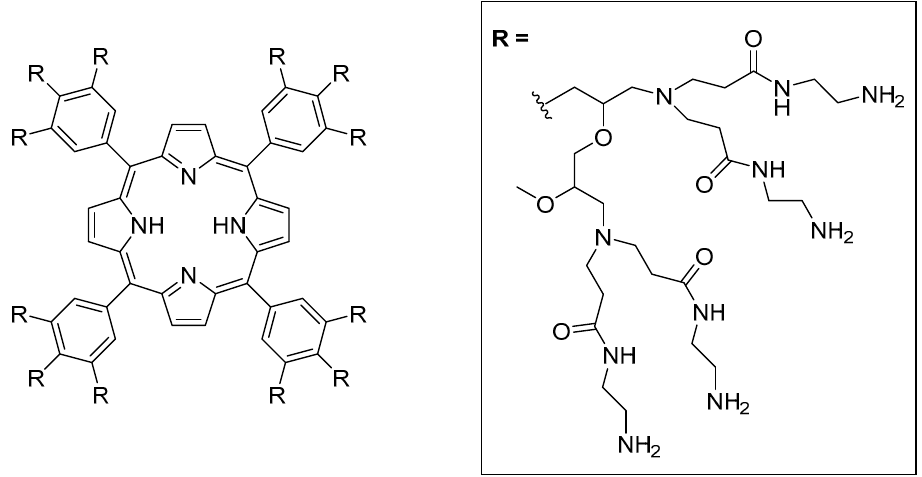
Figure 7. Structure of the catalyst porphyrin cored poly(amidoamine) (G1 POR-PAMAM) dendrimers.